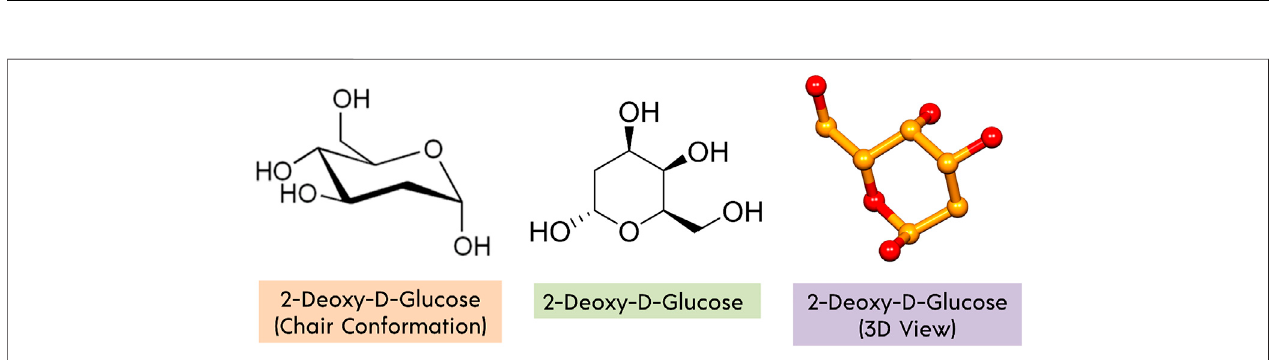
FIGURE 2 | Mechanism of viral replication inhibition by 2-deoxy-D-glucose (2-DG) in SARS-CoV-2 infected host. 1. When a person is infected with SARS-CoV-2, the in fl ammatory action will start in the lower respiratory tract, i.e., lung epithelial cell (magni fi ed view) 2. Glucose provides energy in the form of adenosine triphosphate (ATP) to viral host cells via glycolysis, as well as enabling glycan formation, thus supporting the creation of glycoproteins during glycosylation which helps the virus to replicate. 3. 2-DG as a glucose antimetabolite inhibits glycolysis and glycosylation, which ultimately inhibits viral proliferation.